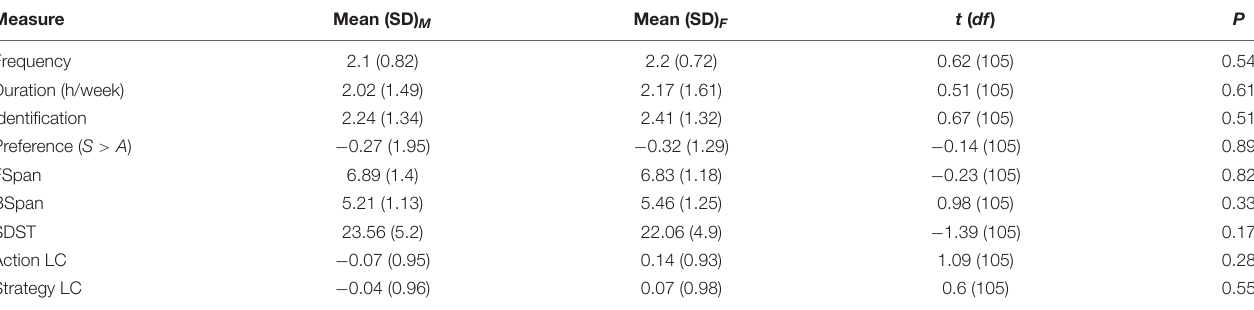
FIGURE 3 | Scatterplots of age–cognition and age–learning relationships, with linear trendiness plotted. Panel (A) depicts the relationship between age and the forward ( FSpan ) and backward ( BSpan ) memory span measures. Panel (B) depicts the relationship between age and the Action LC and Strategy LC. Panel (C) depicts the relationship between age and the Symbol–Digit Substitution Test (SDST). TABLE 2 | Results of T -tests comparing male and female participants on variables of game habits cognition and